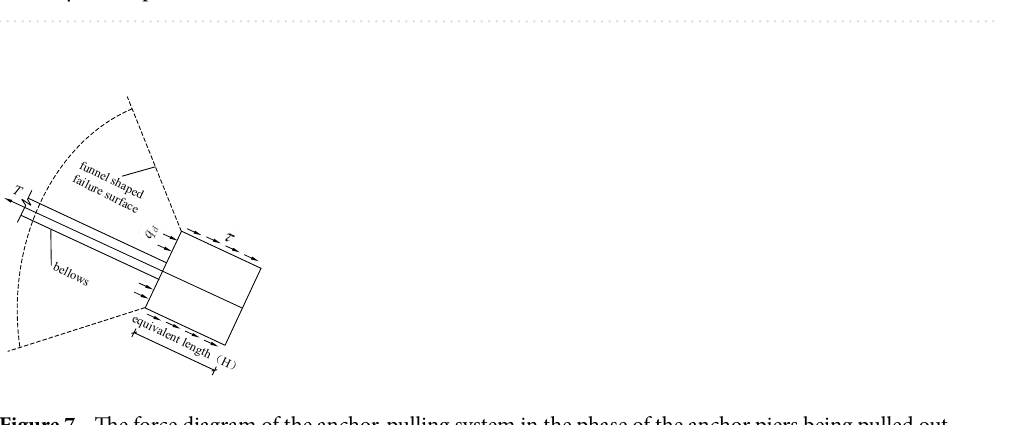
Figure 6. Force diagram of the anchor-pulling system in the phase of compaction-expansion in the plastic zone (stability of compaction).